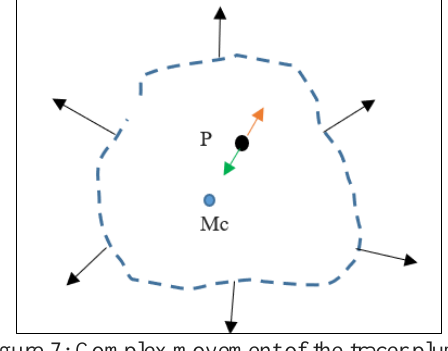
Figure 7: Complex movement of the tracer plume. Source: Authors, (2023).